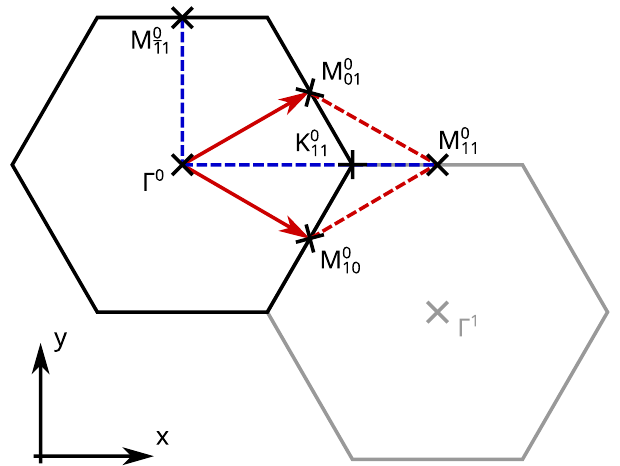
= , M 0 , and M 0 10 10 11